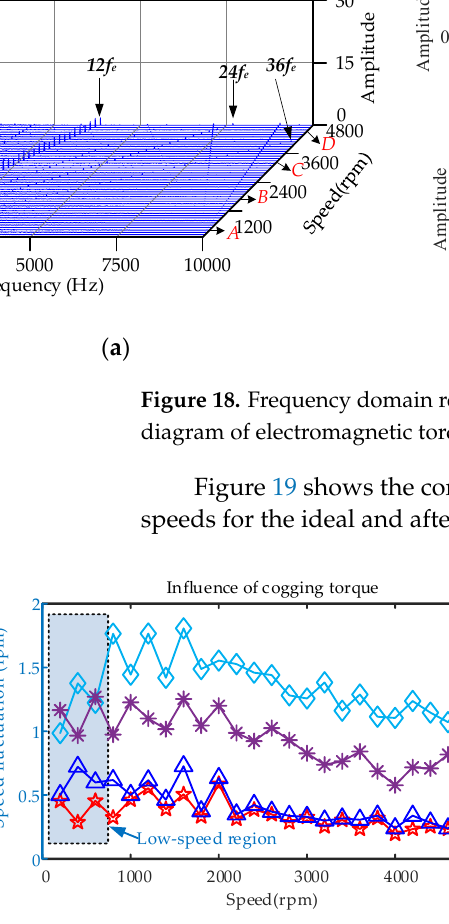
Figure 19. Influence of cogging torque on control performance.